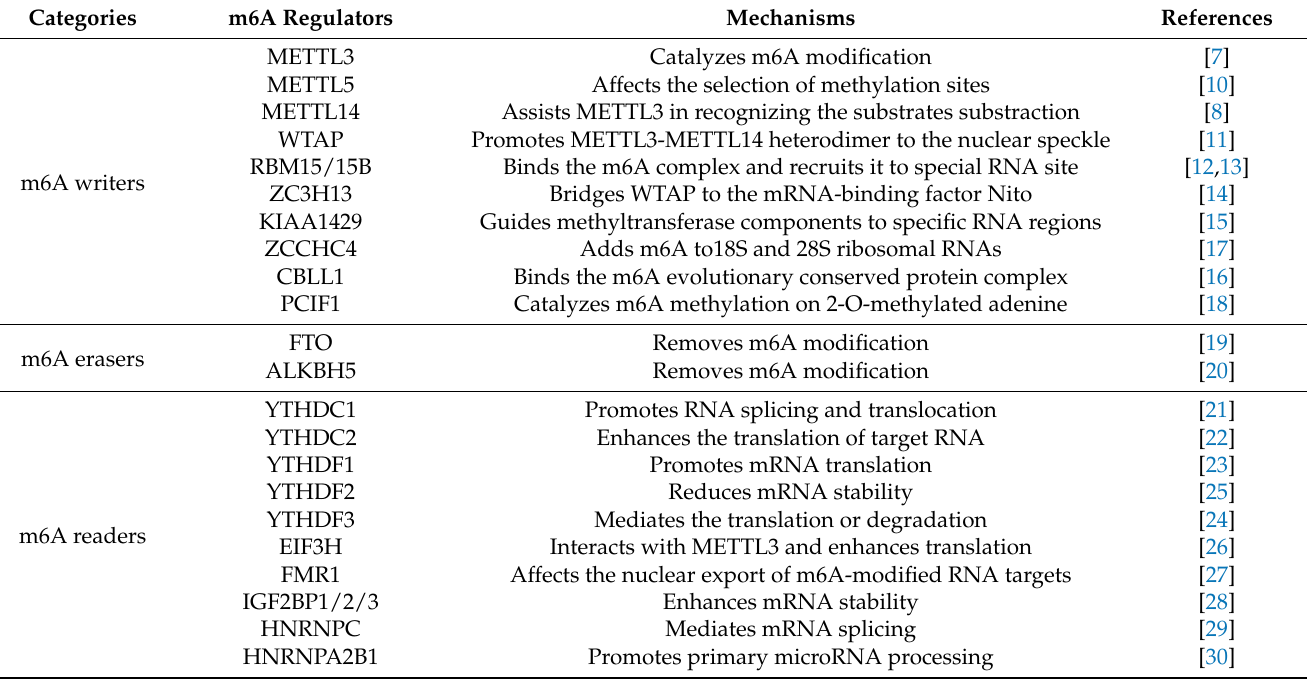
Table 1. List of the 25 m6A regulators included in the current